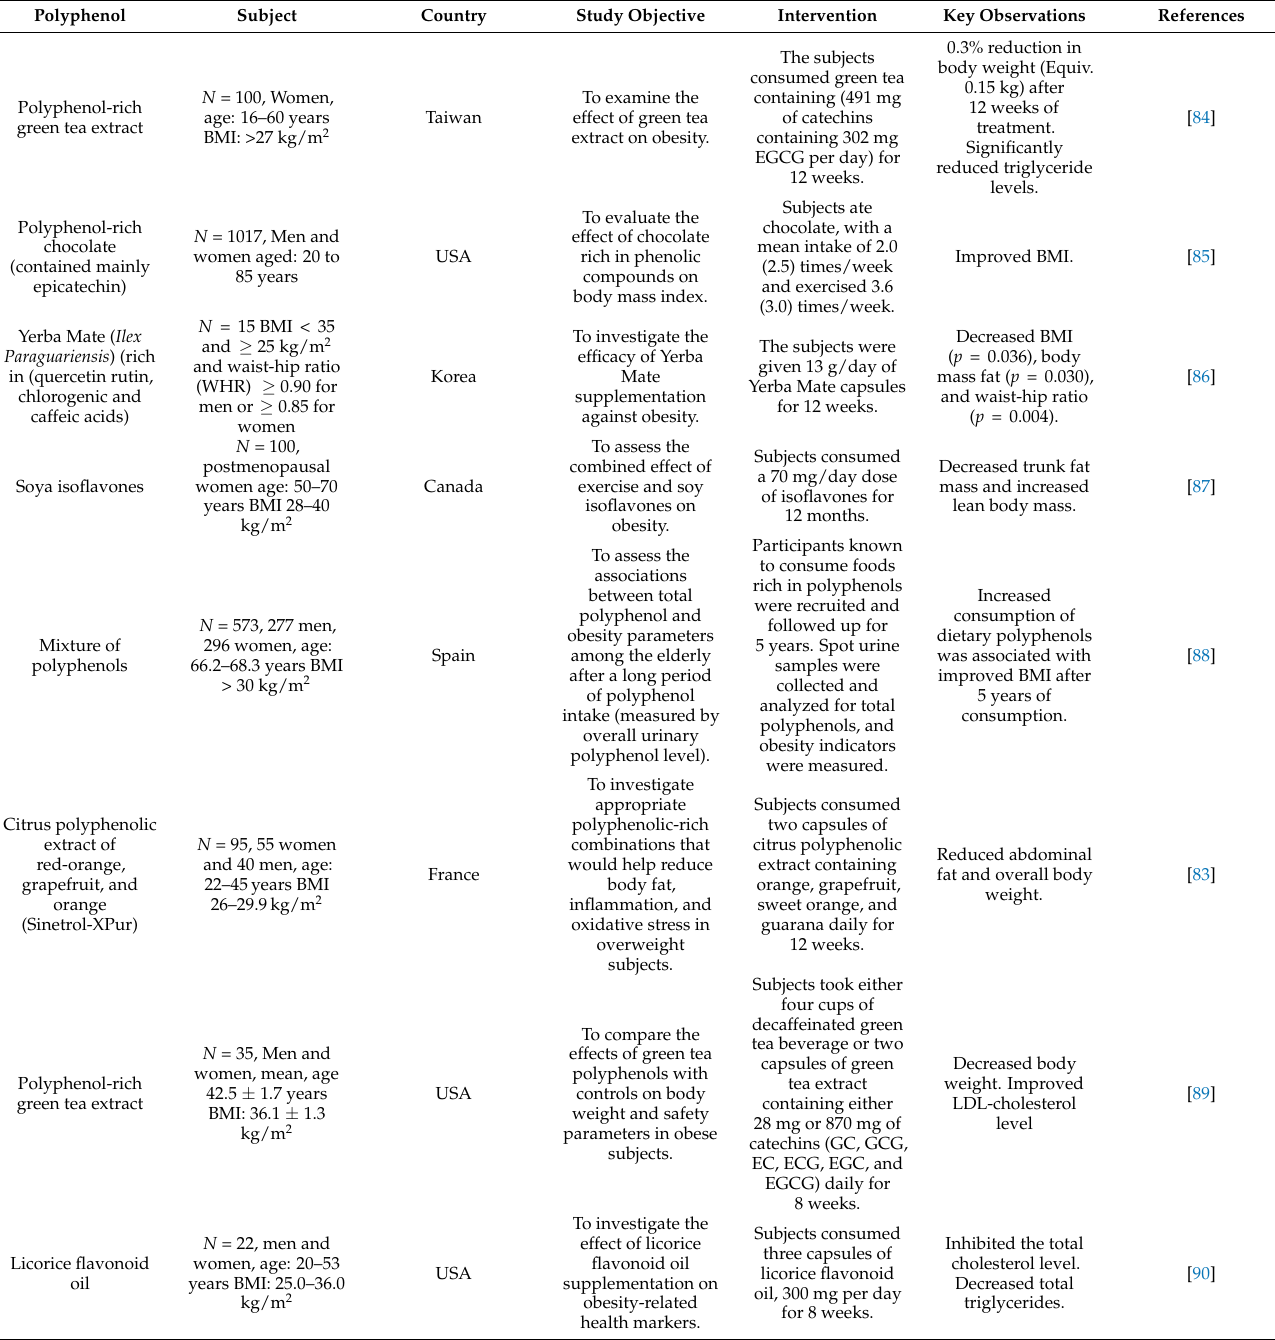
Table 4. Anti-obesity effects of polyphenol-rich extracts in clinical